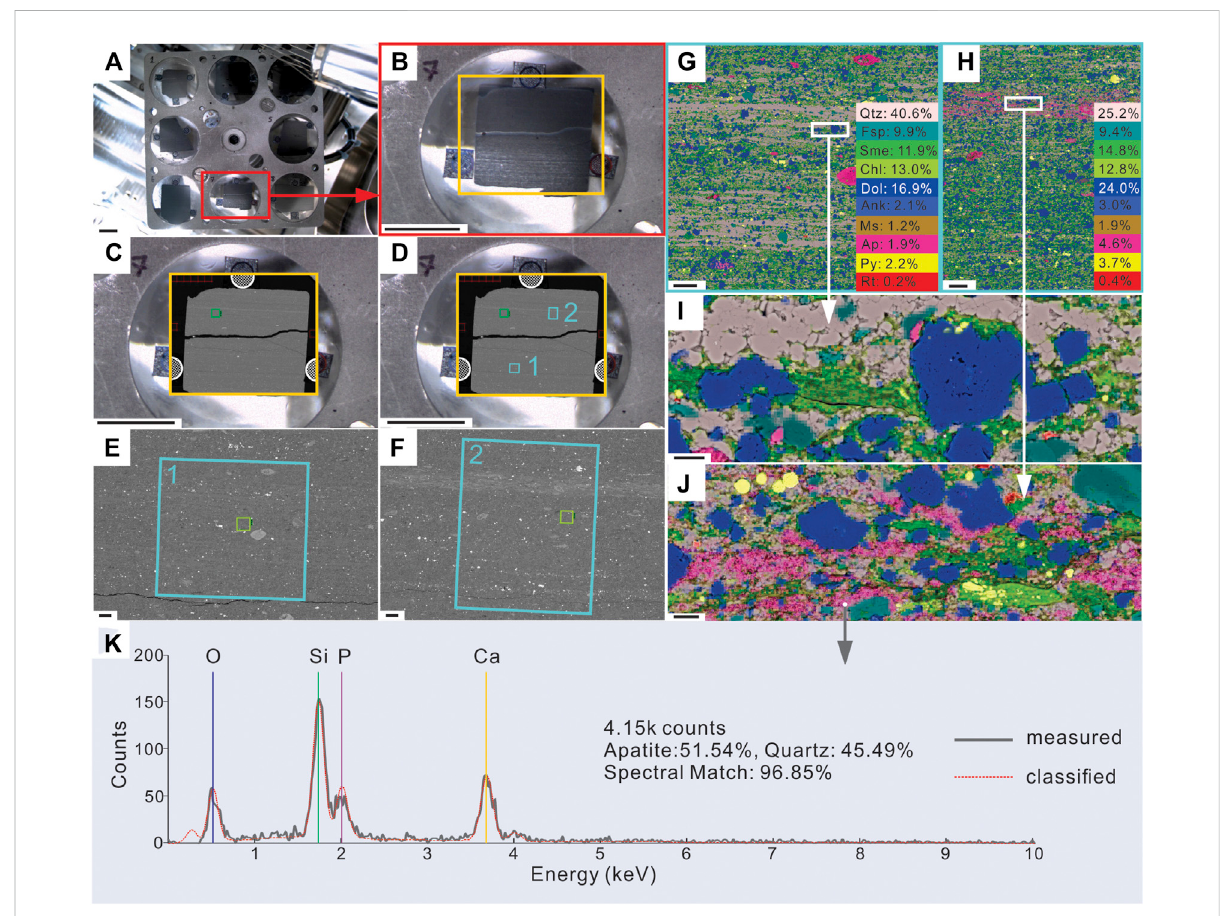
FIGURE 1 Mineral mapping work fl ow, from collection of sample overview BSE image to classi fi cation of an individual EDS spectrum. Scale bars represent 10 mm in (A – D) , 100 μ m in (E – H) , 10 μ m in (I,J) . Minerals identi fi ed and mapped include Qtz, quartz; Fsp, feldspar; Sme: smectite, Chl, chlorite; I, illite; I/S, illite-smectite mixed-layer; Cal, calcite; Dol, dolomite; Ank, ankerite; Ms, muscovite; Ap, apatite; Py, pyrite; Rt, rutile. (A) Nav-Cam photo of the multi-sample stage allowing automated analysis of up to eight samples; (B) zoomed In Nav-Cam image of sample Qlk7, the orange rectangle shows the area selected for collection of a BSE overview scan; (C) stitched BSE overview image of sample Qlk7. The green box outlines a singleBSEtile(1 mm×1 mm,~0.5 µmpixelresolution),theoverviewimagecomprise21×17individualtilesstitchedintoasingleimage; (D) theblue rectangles identify the position of two ROIs selected for higher resolution BSE imaging and mineral mapping (i.e., collection of EDS spectra at 2 µm spacing) (E – F) stitched BSE images of ROIs one and two from (D) , which are comprised of 13 × 12 and 12 × 15 individual tiles respectively. The light green boxes outline a single BSE tile (100 μ m × 100 μ m, ~50 nm pixel resolution). These tiles are smaller than the tiles in (C) and (D) resulting in far better resolution (G,H) false-colour SEM-EDS-based mineral maps overlaid on BSE images of ROIs 1 (G) and 2 (H) , showing mineral proportions. ROI1 contains more quartz and less dolomite or apatite than ROI2, which is also evident in their respective mineral maps; White boxes indicate areas further zoomed in for i and j . (I – J) Zoomed in images showing texture, grain morphology and phase associations (K) an example of a classi fi